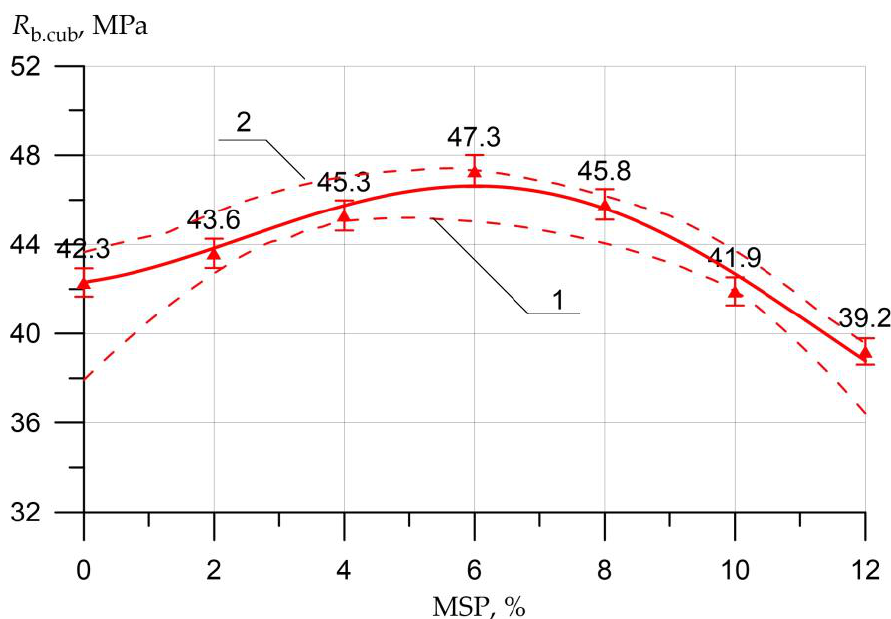
Figure 5. Dependence of the CS of concrete R b.cub on the amount of MSP: 1—lower confidence level; 2—upper confidence level.